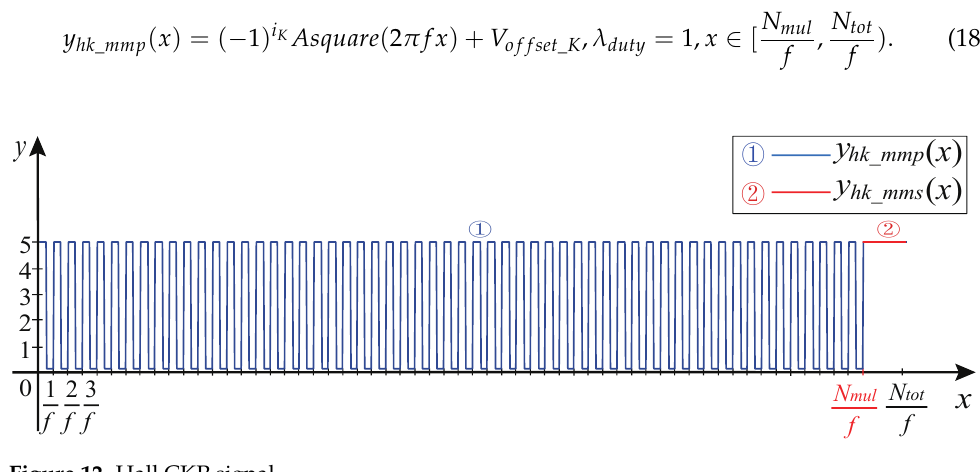
Figure 12. Hall CKP